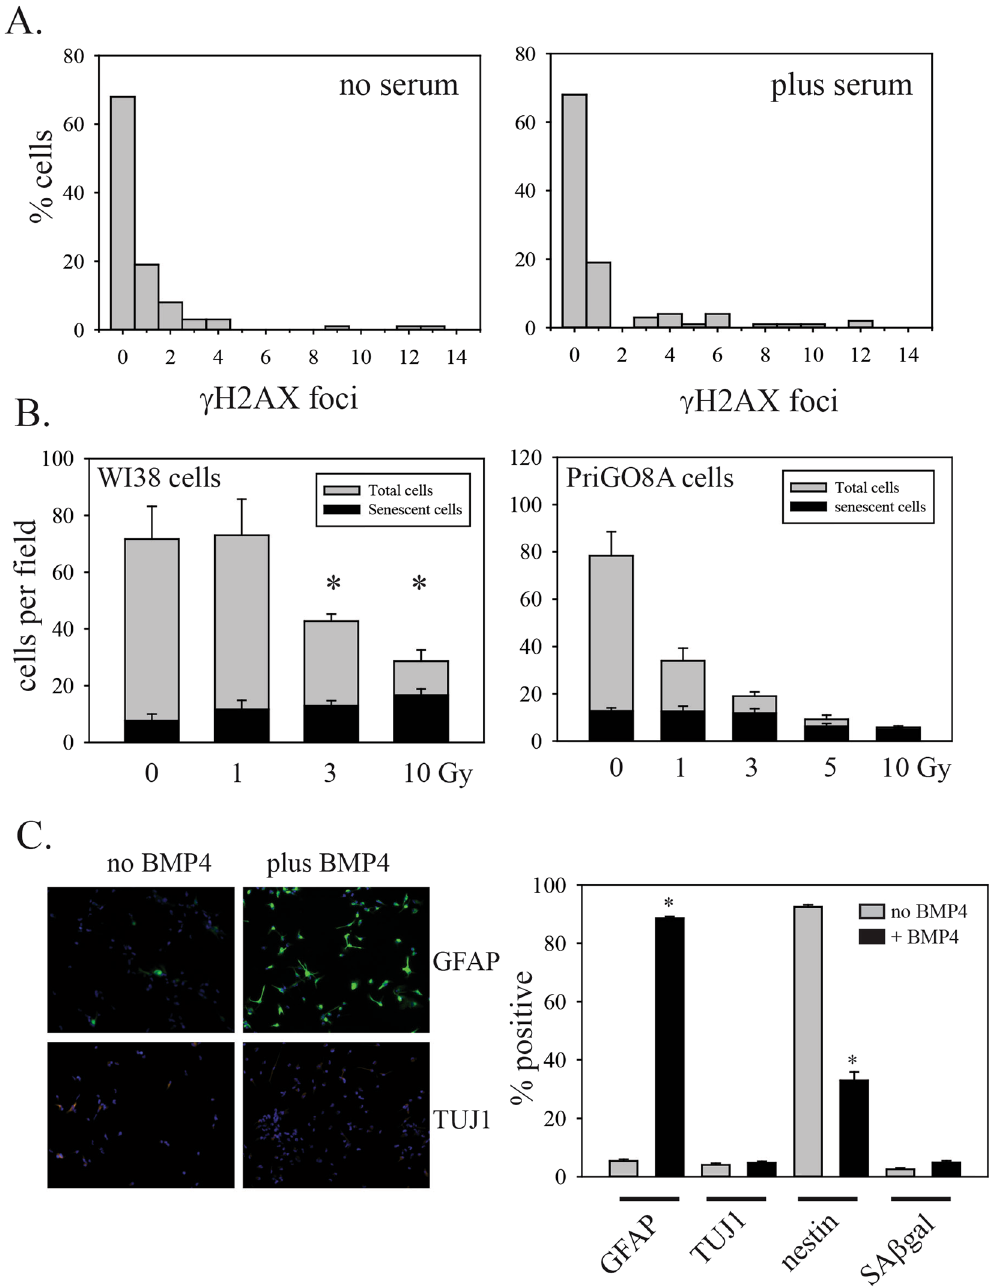
Figure 3. DNA damage and senescence and BMP4-induced differentiation. ( A ) PriGO8A cells were treated without or with serum for seven days. Cells were then fixed and analyzed for γ H2AX foci by immunofluorescence. Data are from approximately 100 cells per condition. The percent of cells with different numbers of foci from 0 to 14 foci per nucleus are plotted. ( B ) WI38 normal human fibroblasts and PriGO8A cells were exposed to the indicated doses of radiation. Seven days later, cells were fixed and stained for SA β gal and total and senescent cells were counted in randomly chosen fields. Statistical significance was determined using two-tailed t tests. * Indicates p < 0.05 for a change in senescent cell numbers relative to 0 Gy radiation. Representative images of PriGO8A and WI38 γ H2AX immunofluorescence are shown in Supplementary Figure S1. ( C ) PriGO8A cells were treated without or with 100 ng/ml BMP4. Seven days later cells were fixed and assayed for GFAP, TUJ1 and nestin expression by immunofluorescence. SA β gal assays were performed as described in Materials and Methods. Representative images of GFAP and TUJ1 immunofluorescence are shown. The bar graph shows quantitation of GFAP, TUJ1, nestin and SA β gal positive cells. Data are from five randomly selected fields per condition. Statistical significance was determined using two-tailed t tests. * Indicates p <